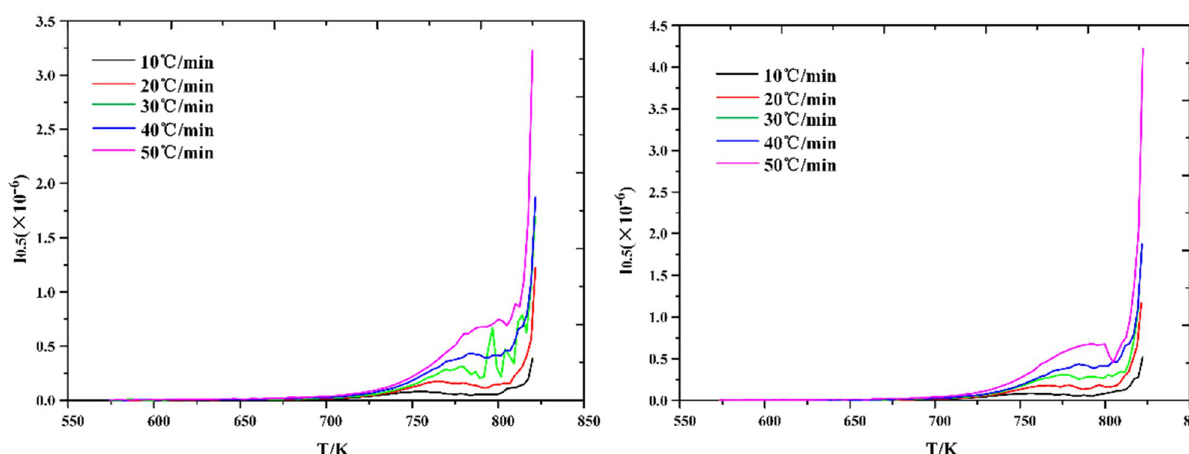
Figure 14. Volatile release characteristic index ( a ) N 2 ( b ) CO 2